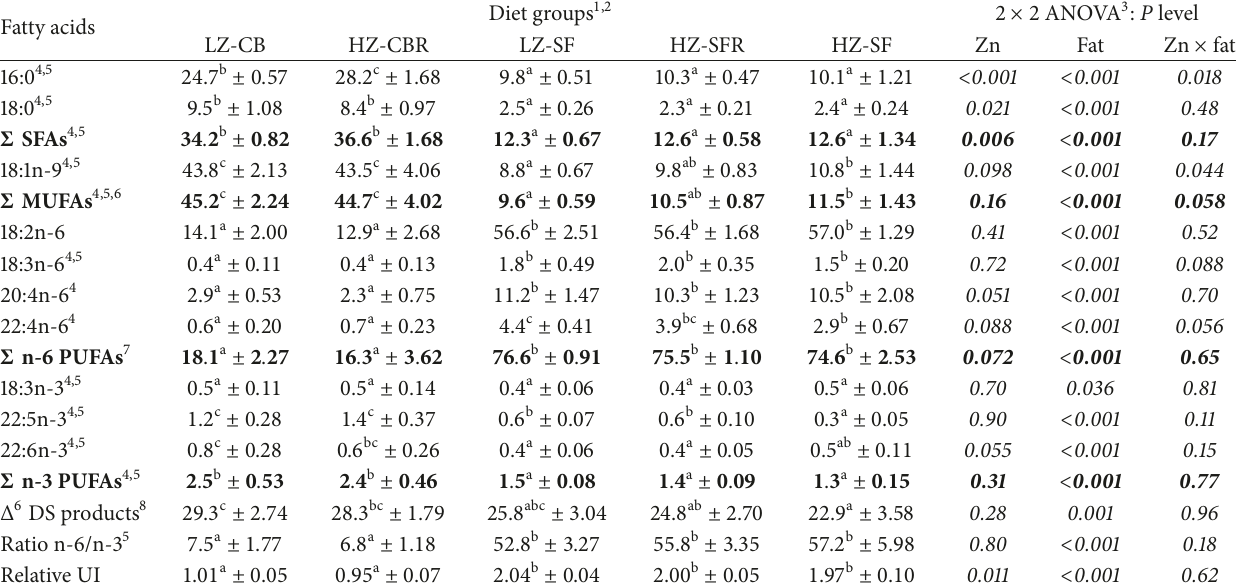
Table 5: Fatty acid composition (mol/100mol) of liver triacylglycerols in male weanling rats fed high-fat diets differing in Zn content and fat source free choice or in restricted amounts for 4